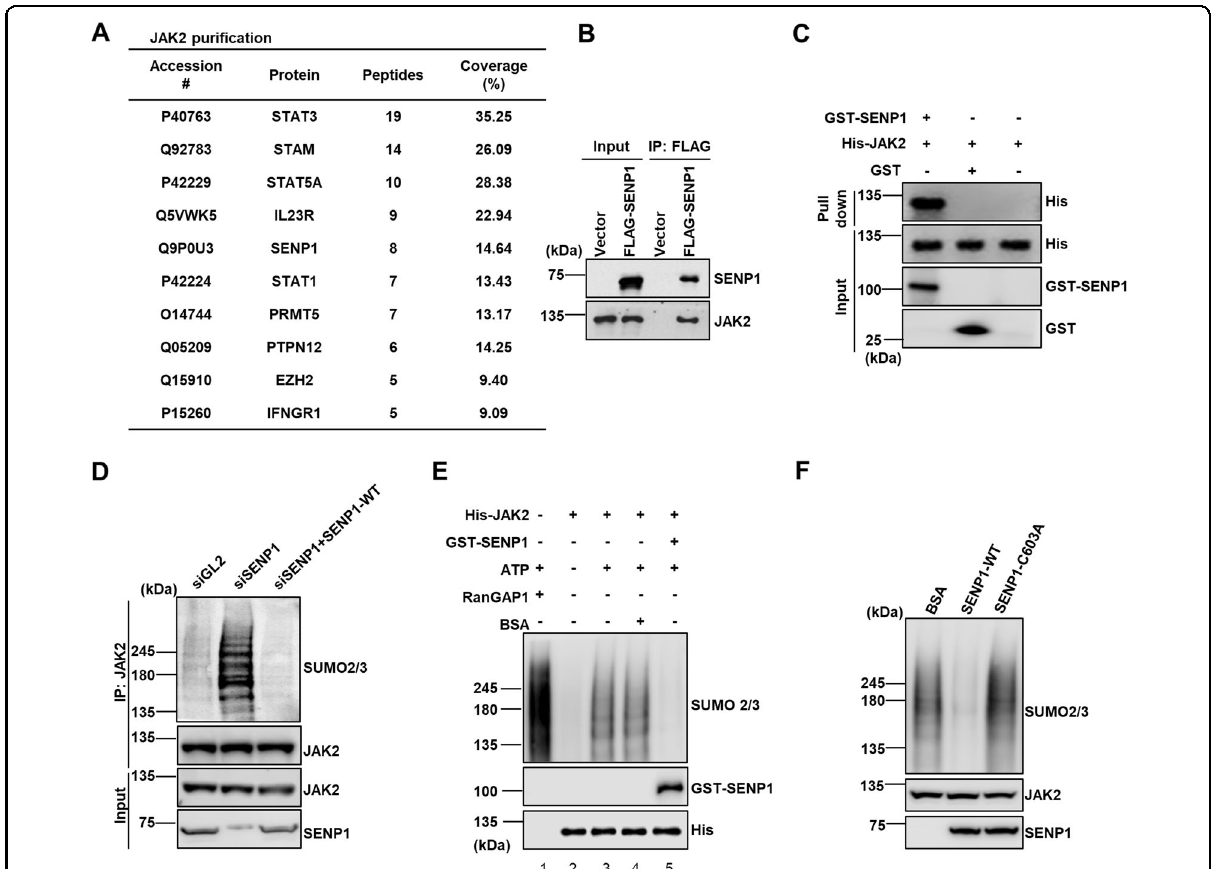
Fig. 1 Identi fi cation of SENP1 that directly interacts with and deSUMOylates JAK2. A Mass spectrometry analysis to identify JAK2 associated proteins. Immunoprecipitation of His-tagged JAK2 from HEK293T cells was used for mass-spec analysis. Results represent the proteins identi fi ed in cells expressing His-hJAK2 compared cells expressing empty vector. Peptides were fi ltered to exclude false positives. B SENP1 interacts with JAK2 in vivo. Co-IPs of Flag-SENP1 were analyzed by Western blot using indicated antibodies. C SENP1 interacts with JAK2 in vitro. Recombinant GST- SENP1 was used to capture His-JAK2 protein on glutathione agarose as described in “ Materials and Methods ” . D Ectopic expression of